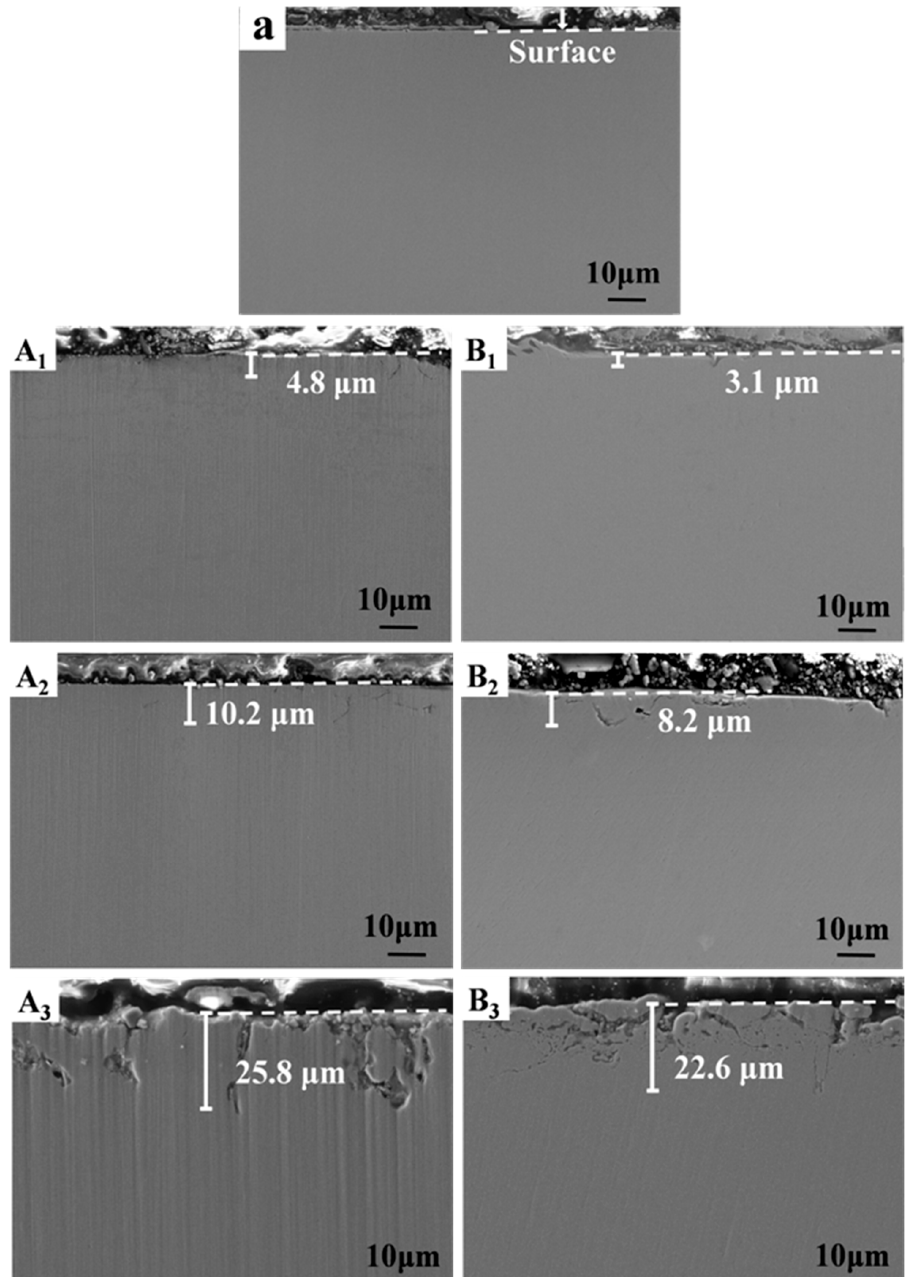
Figure 4. Cross-sectional SEM images of the original 316SS (a), corroded 316SS exposed in salts A (A 1 ,A 2 ,A 3 ) and B (B 1 ,B 2 ,B 3 ) under Ar for 100 h at 500 °C (A 1 ,B 1 ), 600 °C (A 2 ,B 2 ) and 700 °C (A 3 , B 3 ).